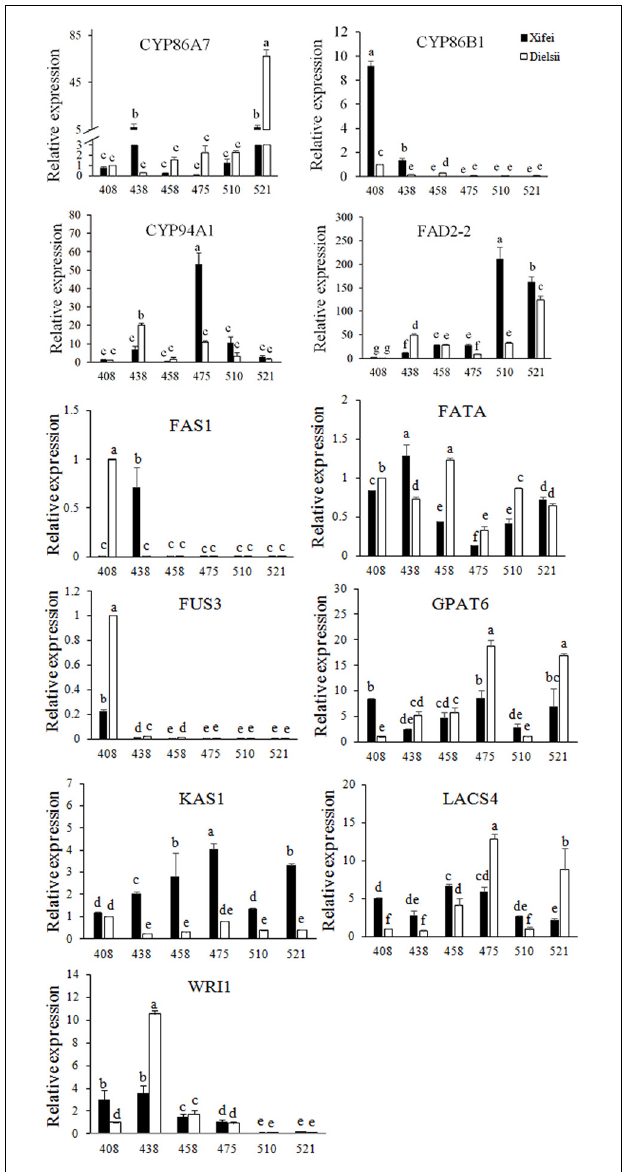
FIGURE 4 | RT-qPCR of 11 DEGs related to fatty acid biosynthesis and metabolism measured during development. Relative expression of DEGs was shown with means of triplicates. Samples were collected at 408, 438, 458, 475, 510, and 521 days after pollination (DAP). The dark square represents T. grandis ‘Xifei.’ White square represents T. grandis ‘Dielsii.’ The significant difference of the DEG expression between development stages were labelled with a to g according to Duncan’s multiple comparison test ( P <